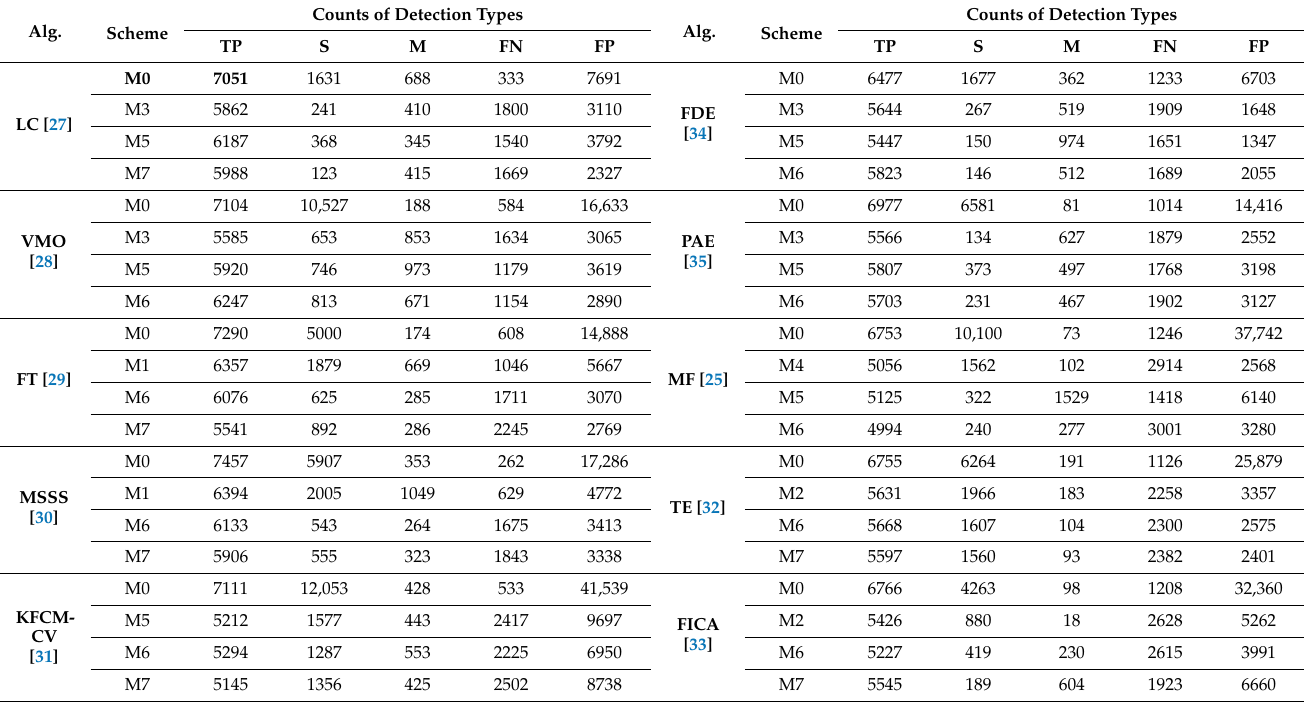
Table 4. Types of detections for each algorithm combined with each of the best three schemes from Table